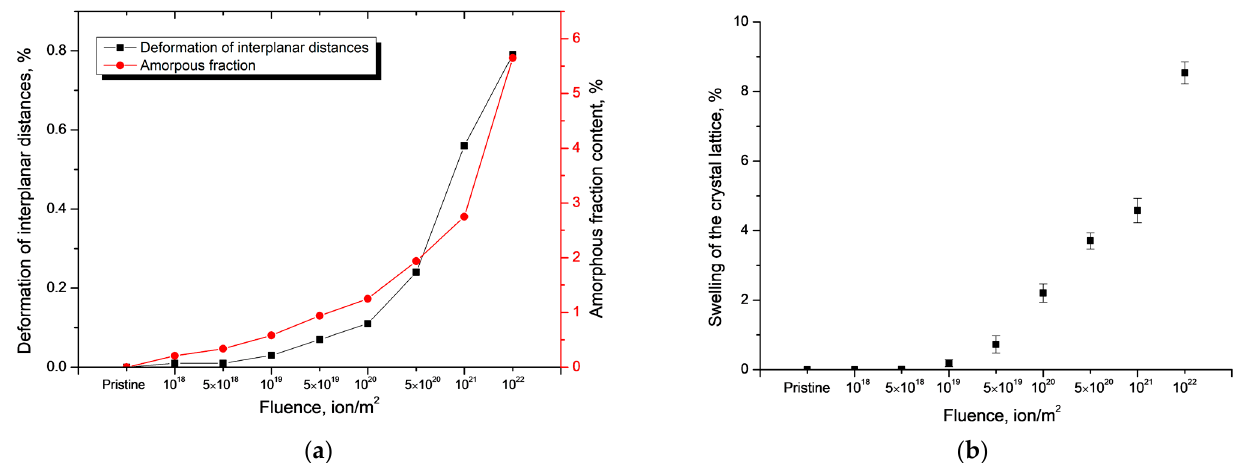
Figure 3. ( a ) Changes in the values of the degree of deformation of interplanar distances and the content of amorphous inclusions; ( b ) crystal lattice swelling versus irradiation fluence.